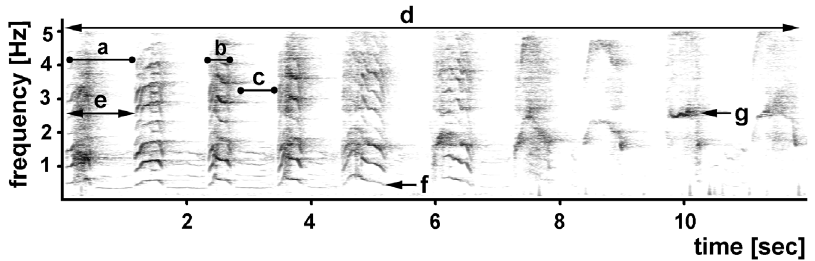
Figure 1. Sample spectrogram of a simakobu loud call indicating the parameters measured in the acoustic analysis: (a) call unit, (b) huh, (c) hoo, (d) duration, (e) inter-unit interval, (f) fundamental frequency, and (g) peak frequency.